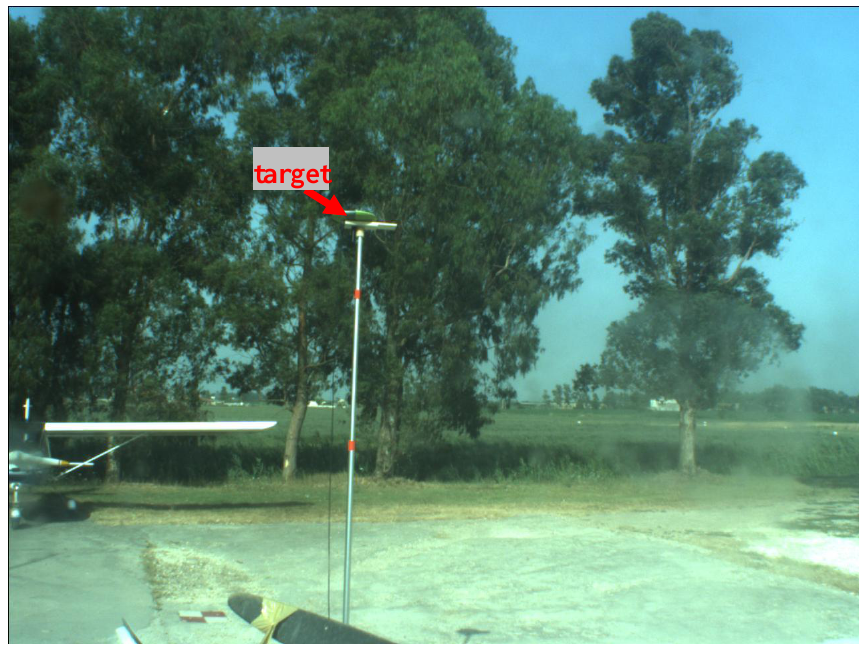
Figure 6. Example of color image taken during alignment